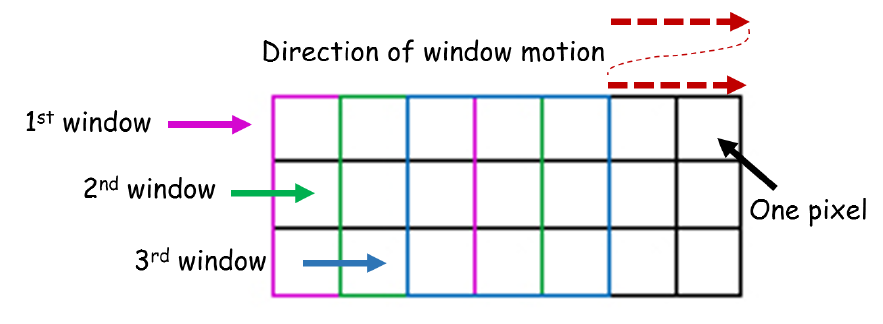
Figure 5. Sliding window method used for data preprocessing: 512 × 512 pixel moving window slides through the image with a setting distance (half of the sample size) each time to get a